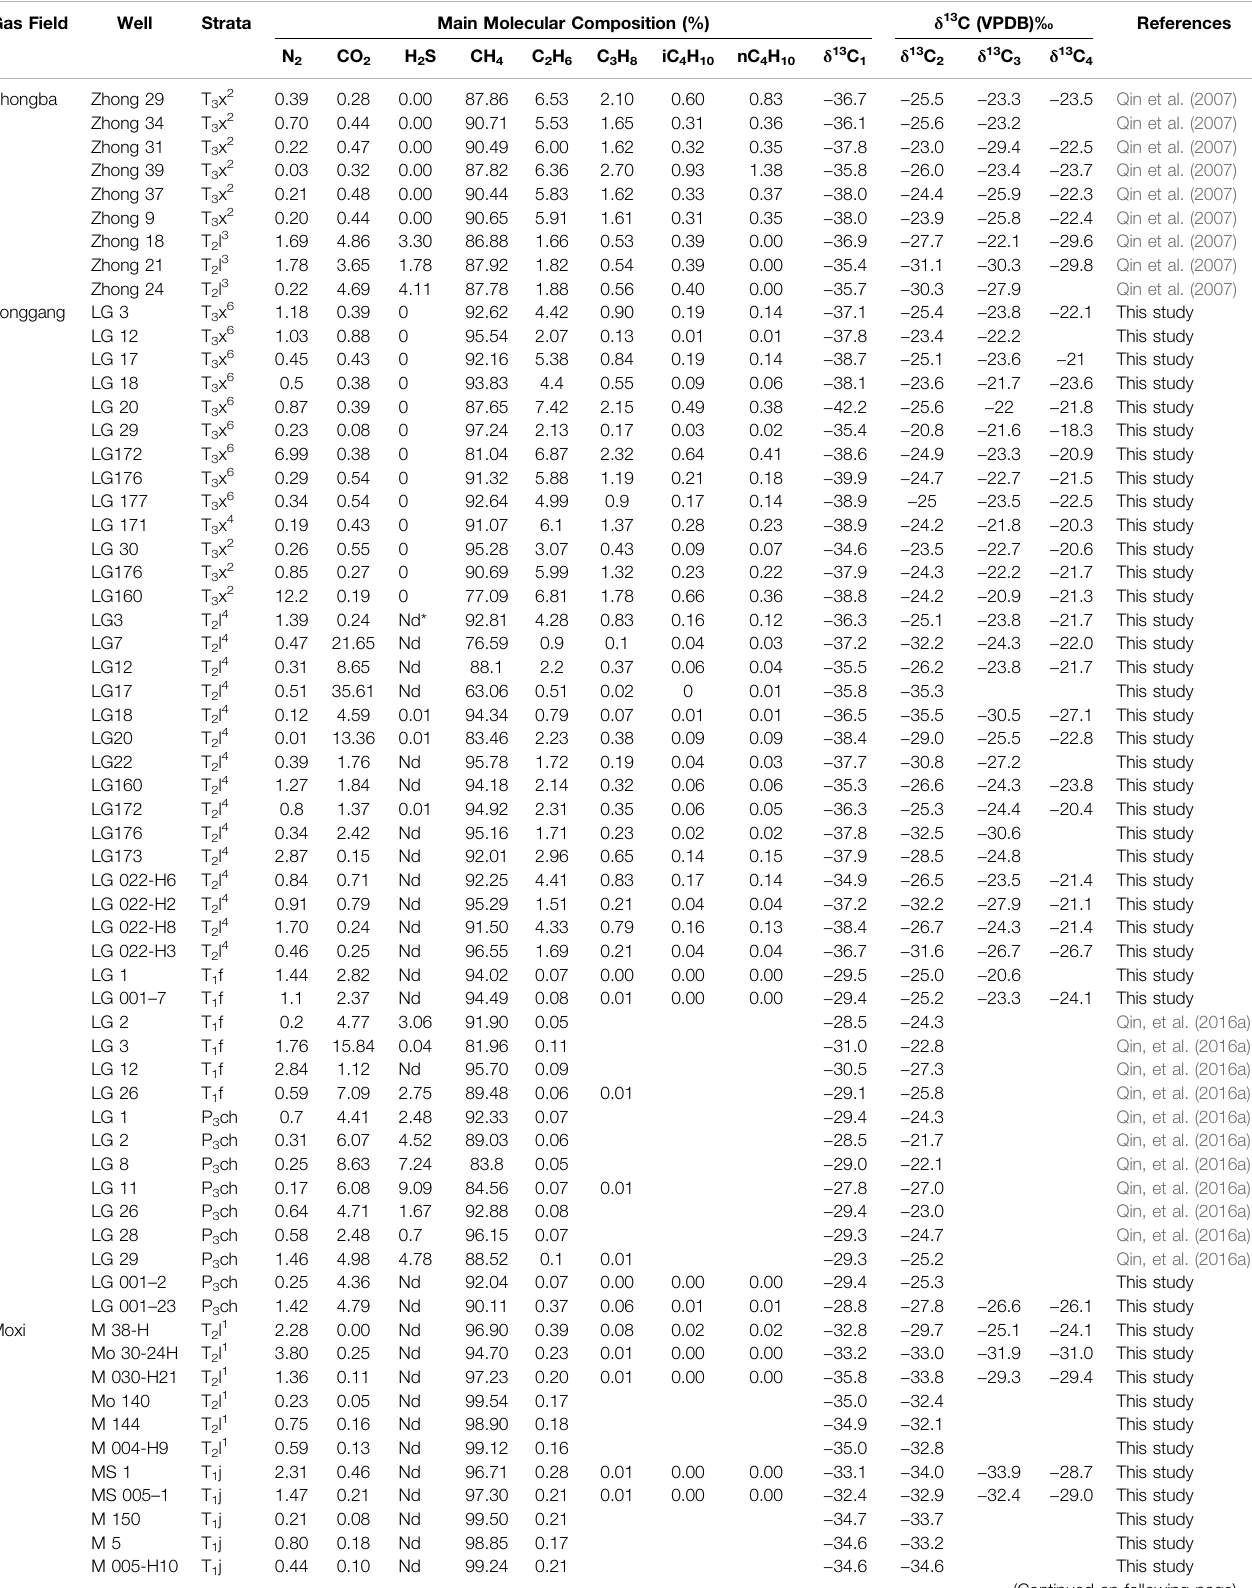
TABLE 1 | Composition and isotopic data of Permian and Triassic natural gas in the central Sichuan Basin. Gas Field